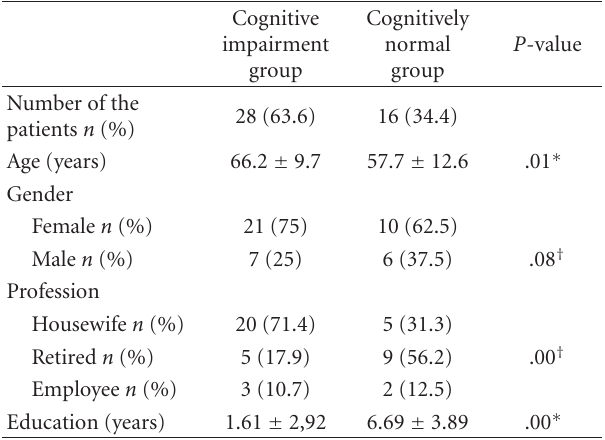
Table 1: Clinical characteristics of the patients.